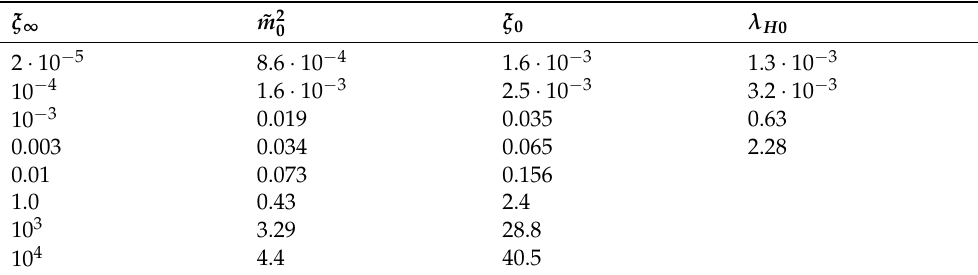
Table 1. Values of parameters at ˜ ρ = 0 for asymptotic scaling solutions with different parameters ξ ∞ . We show the dimensionless mass term ˜ m 2 , the nonminimal scalar-gravity coupling ξ 0 , and the 0 quartic scalar coupling λ H 0 . For ξ ∞ ≥ 0.01, the quartic scalar coupling gets very large and is not displayed here.